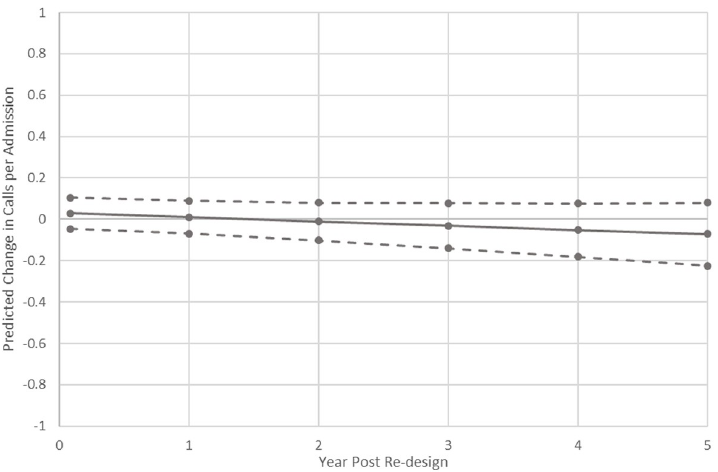
Fig 4. Final multivariable model. Cumulative predicted change in calls per admission associated with the RRS re- design, with 95% confidence